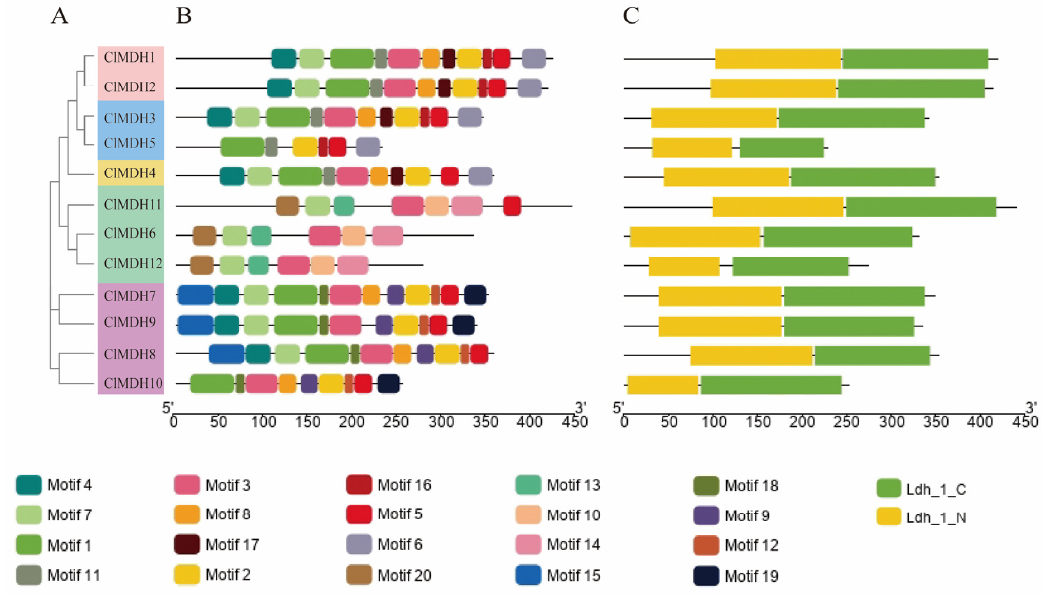
Figure 3. The unrooted phylogenetic tree, conserved motifs and domain of ClMDH genes. ( A ) The neighbor-joining tree on the left comprised 12 motifs. ( B ) Conserved motifs were represented via boxes, and different colors represent different motifs. ( C ) Conserved domain of ClMDH genes; yellow color indicates the Ldh_1_N, green color indicates the Ldh_1_C.